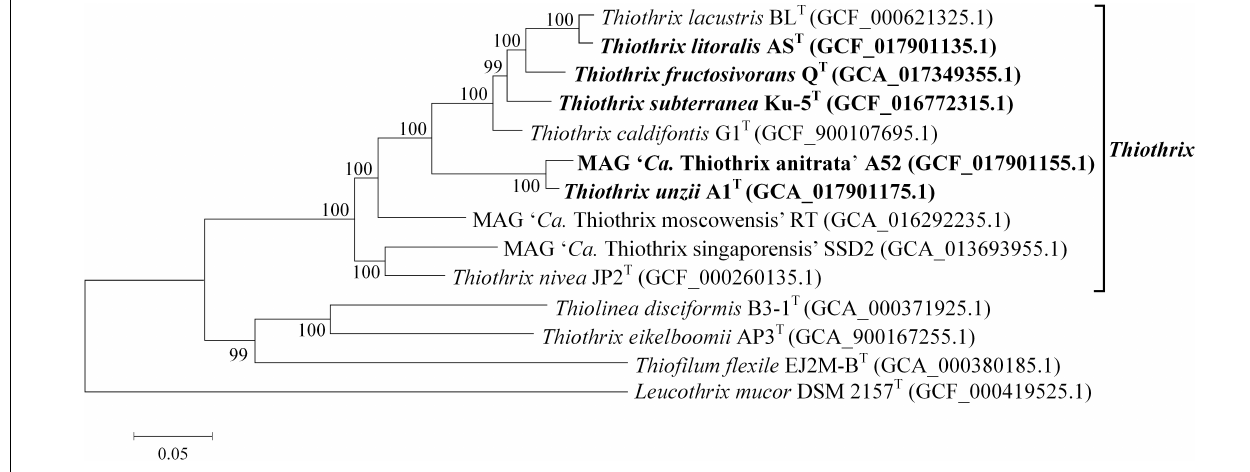
FIGURE 3 | Phylogenetic tree of Thiothrix species. Position of Thiothrix genomes in the maximum-likelihood are determined by concatenated protein phylogeny. GenBank assembly accession numbers are shown after the genome names. The levels of support for internal branches assessed using the Bayesian test in PhyML are indicated at the nodes. The genome of Leucothrix mucor DSM 2157 T was used to root the tree. Note that Thiothrix eikelboomii actually belongs to the genus Thiolinea (Boden and Scott, 2018) but was not yet formally reclassified. The species whose genomes are described in this work are highlighted in